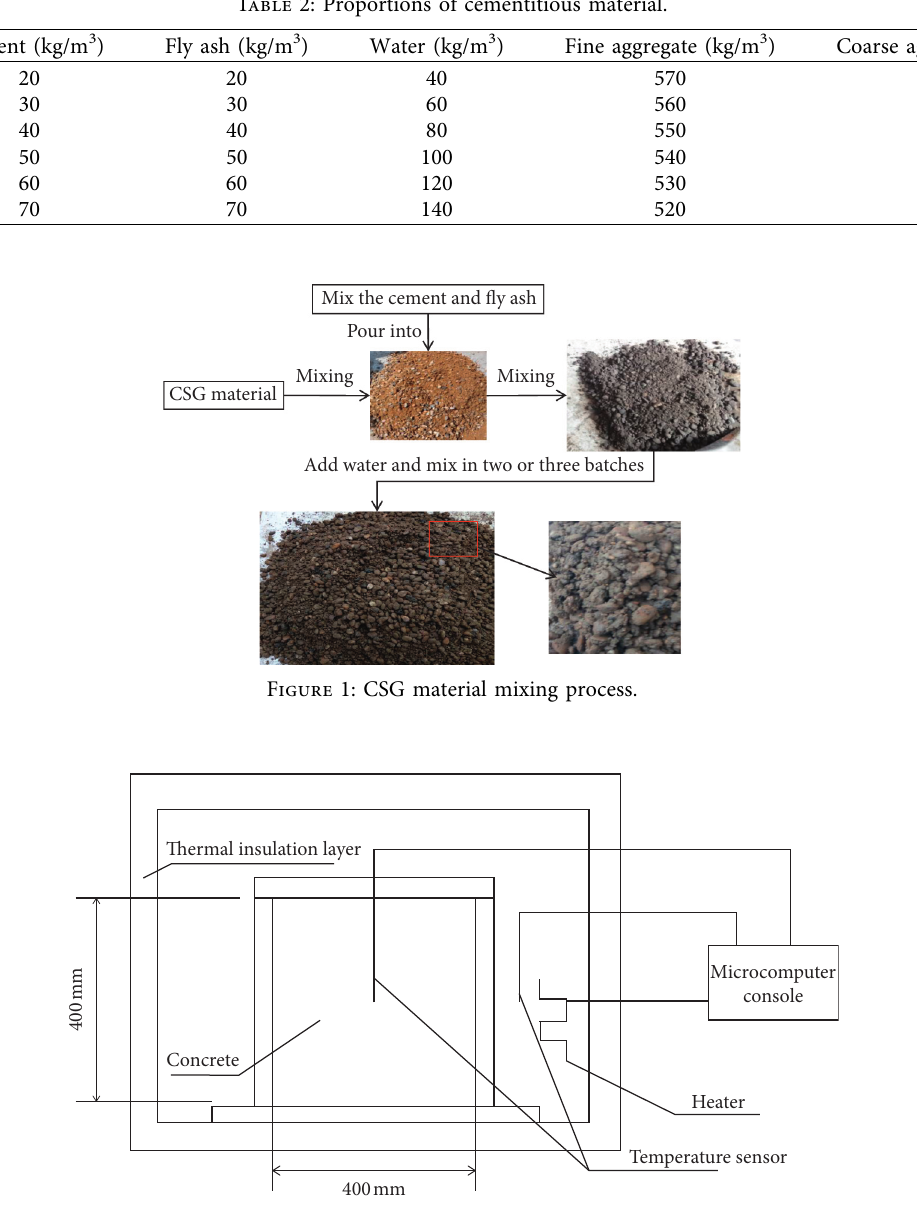
Figure 2: Schematic diagram of IMJR-500 concrete adiabatic temperature rise